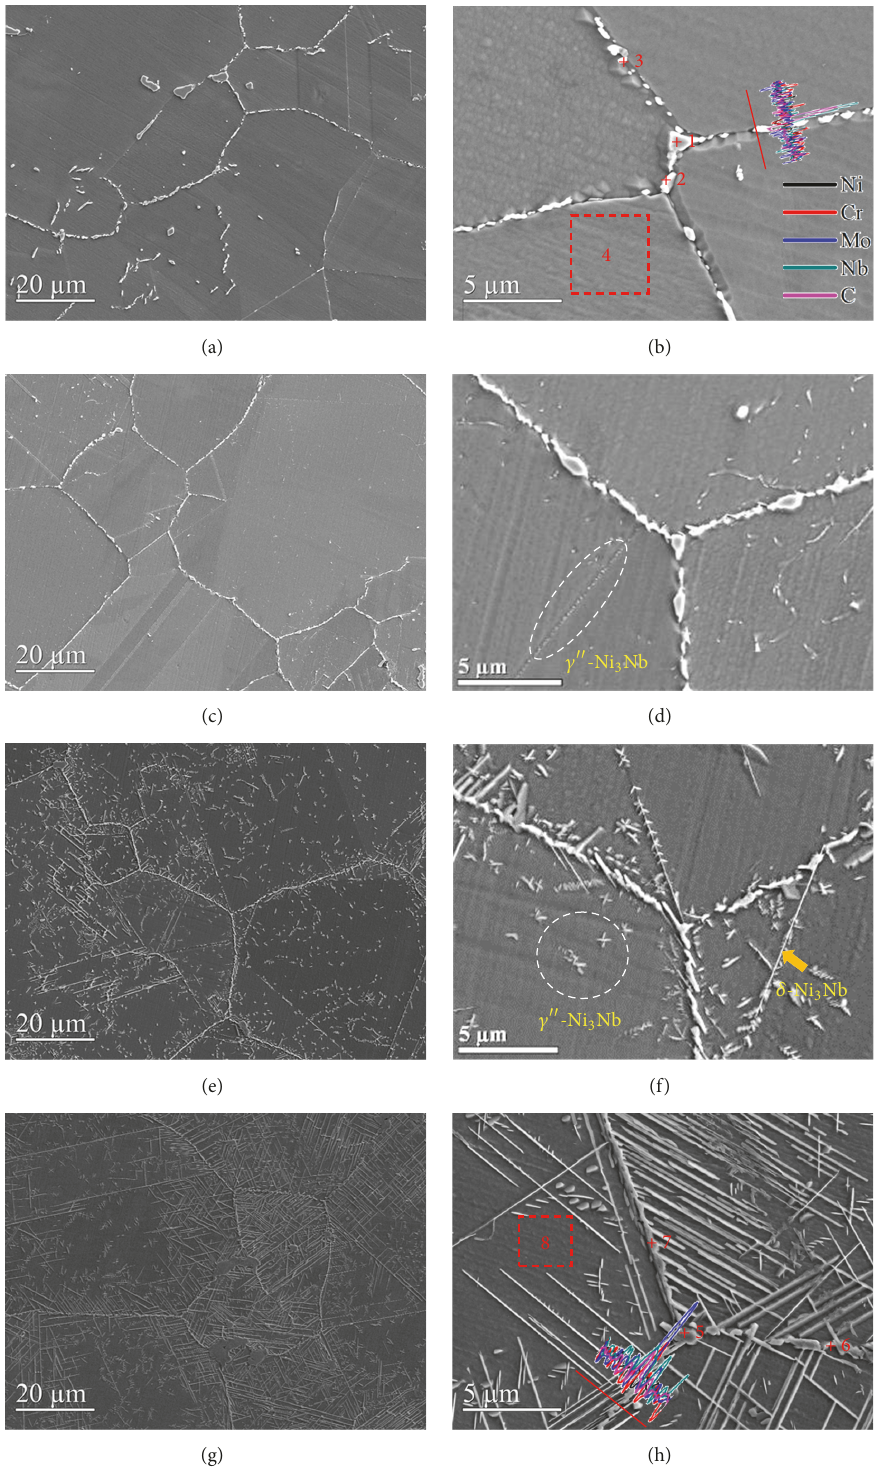
Figure 2: Microstructure of Alloy 625 after aging sensitization for different times. (a),(b) 0h; (c),(d)40h; (e), (f)200h;